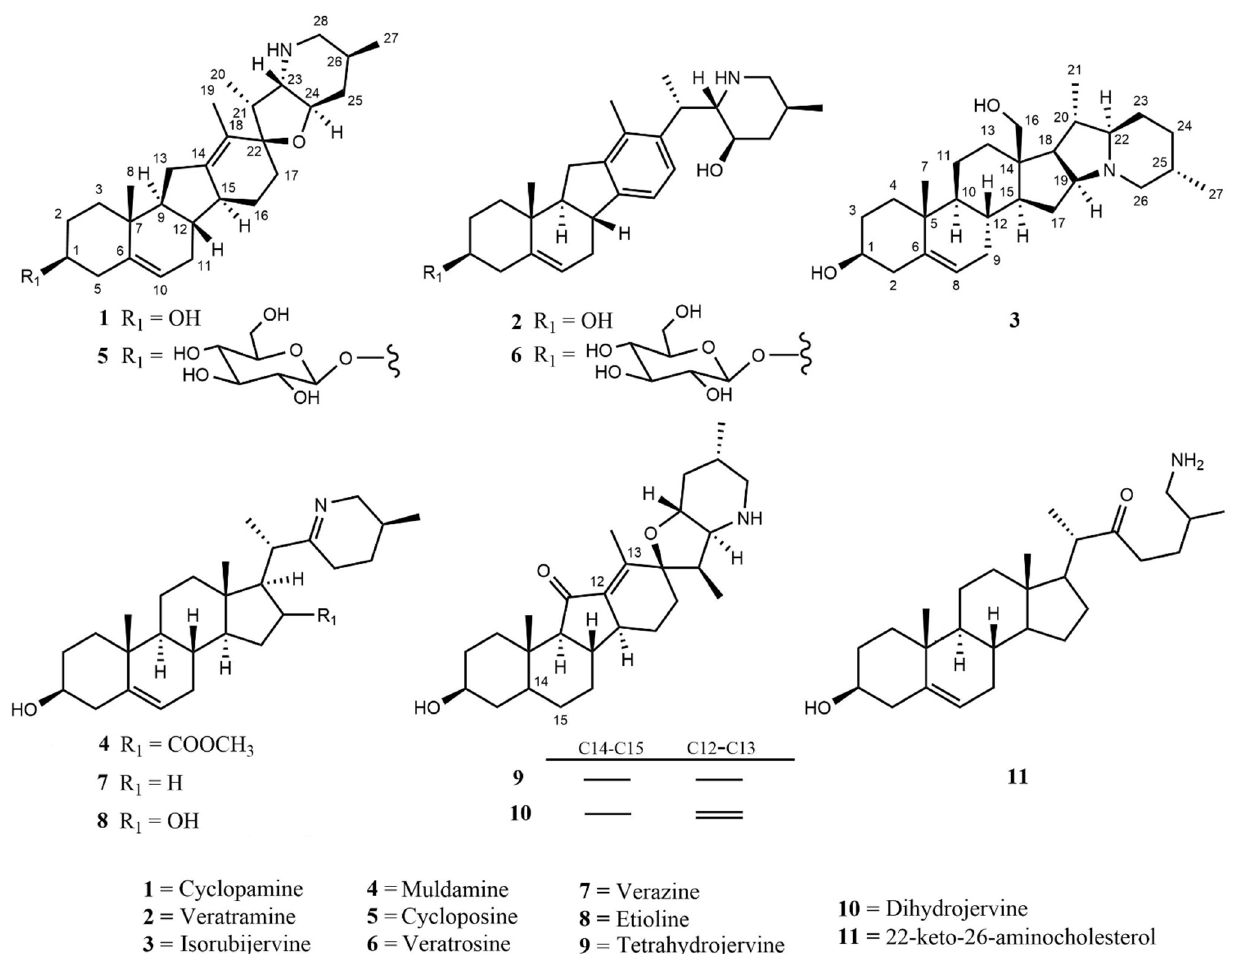
Figure 1. Structures of 11 known and proposed alkaloids in Veratrum californicum. Interest in the Veratrum genus is attributable to the medicinal and therapeutic prop-